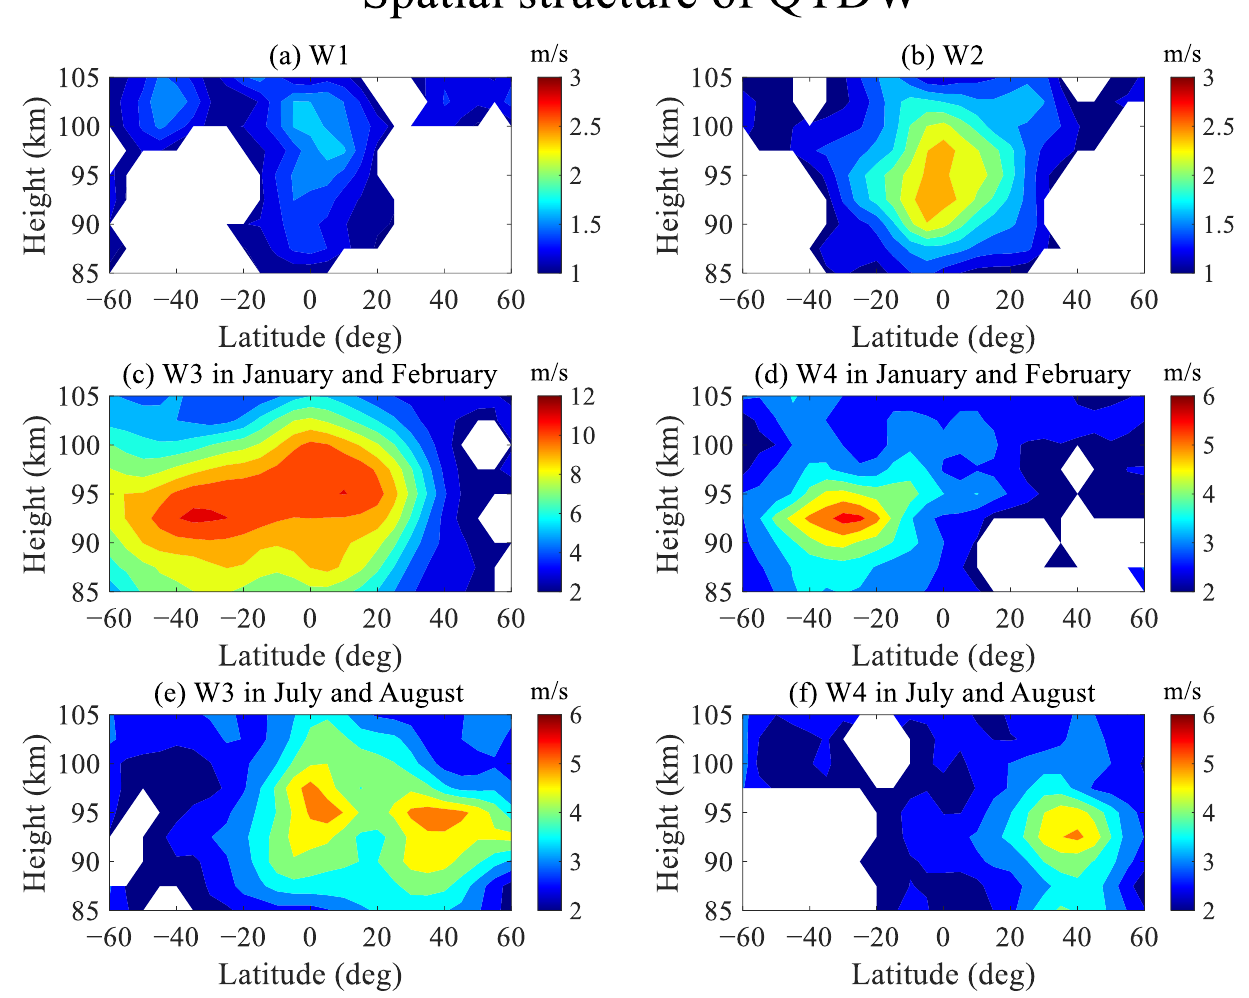
Figure 6. The spatial structures of ( a ) W1, ( b ) W2, and ( c ) W3 in January and February, ( d ) W4 in January and February, ( e ) W3 in July and August, and ( f ) W4 in July and August QTDWs in meridional wind between 82 km and 96 km at latitudes of 60°S to 60°N from 2003 to 2012.